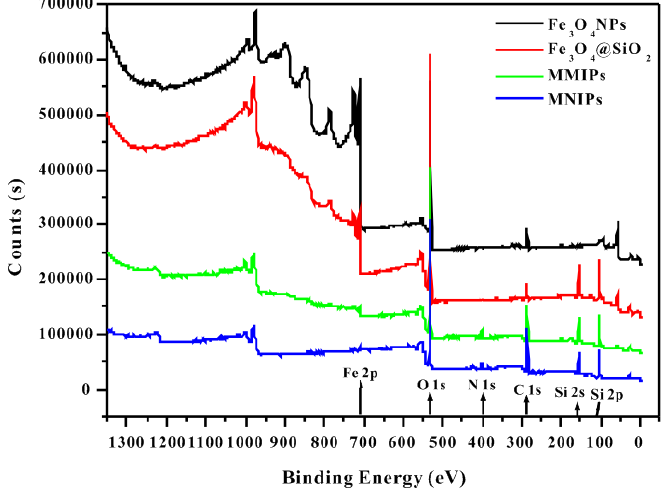
Figure 6. XPS spectra of the four polymers (Fe 3 O 4 NPs, Fe 3 O 4 @SiO 2 , MMIPs, and MNIPs).